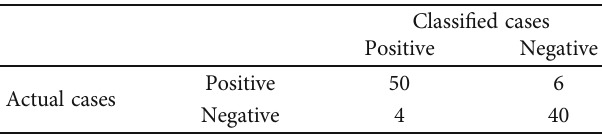
Table 6: Floating-point operations per second and training CPU time of training of all methods.